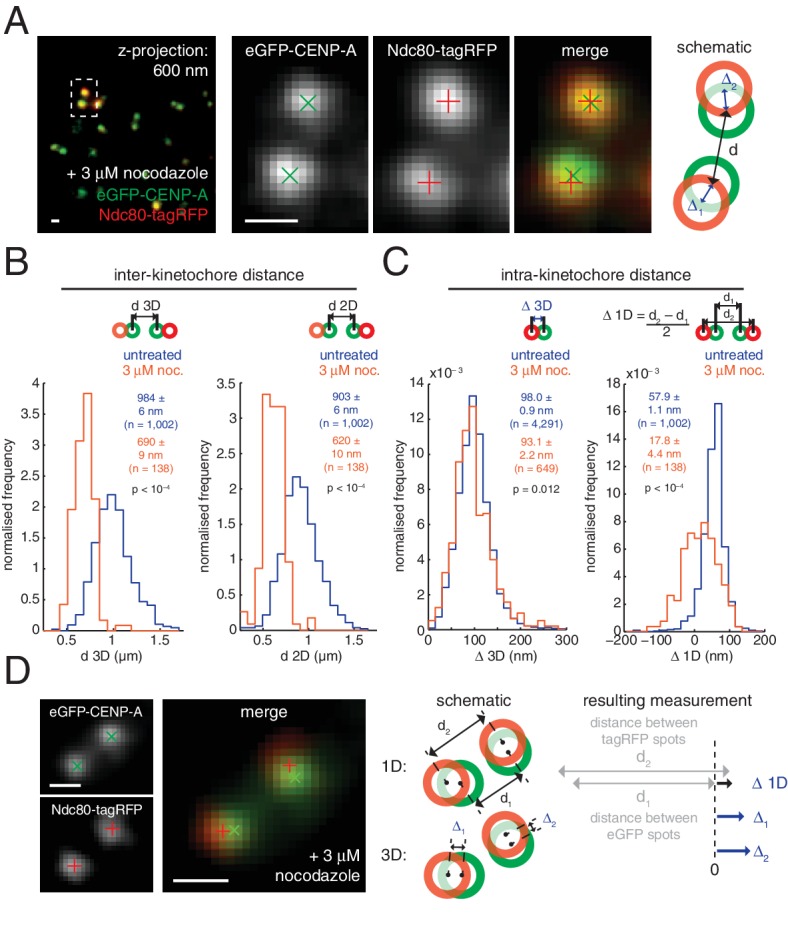
Nocodazole treatment marginally decreases 3D intra-kinetochore distance.(A) Live cell imaging of eGFP-CENP-A and Ndc80-tagRFP after 3 µM nocodazole treatment (600 nm z-projection). Representative images of a kinetochore pair demonstrating Gaussian-fitted spot centres. Schematic of the kinetochore pair shows measurements of intra-, Δ, and inter-kinetochore distances, d. Scale bars 500 nm. (B) Distribution of measurements of inter-sister distance d in 3D (left panel) and 2D (right panel), in untreated (blue; n = 1002) and 3 µM nocodazole treated cells (gold; n = 138); both are significantly different (p < 10–4). (C) Distribution of measurements of intra-kinetochore distance Δ in 3D (left panel) and 1D (right panel), in untreated (blue; n3D = 4291, n1D = 1002) and 3 µM nocodazole-treated cells (gold; n3D = 649, n1D = 138); both are significantly different to 95% confidence. In (B) and (C), schematics illustrate measurement method, statistical tests were Mann-Whitney U tests, and values given are medians ± standard error. (D) Example of a kinetochore pair demonstrating rotation of the kinetochore axis relative to the sister-sister axis. Schematic illustrates how 1D and 3D measurements of Δ are made, and the resulting underestimate of Δ 1D. Scale bars 500 nm.DOI:
http://dx.doi.org/10.7554/eLife.16159.00810.7554/eLife.16159.009Figure 2—source data 1.Swivel increases under nocodazole treatment for multiple kinetochore markers.Table of measurements of Δ 1D, Δ 2D, ϑ 3D-swivel and standard deviation of ϑ y-swivel distribution for all kinetochore markers imaged in untreated and 3 µM nocodazole-treated cells. n values correspond to all measurements in columns to the left of the n-value column. Values given are medians ± standard error.